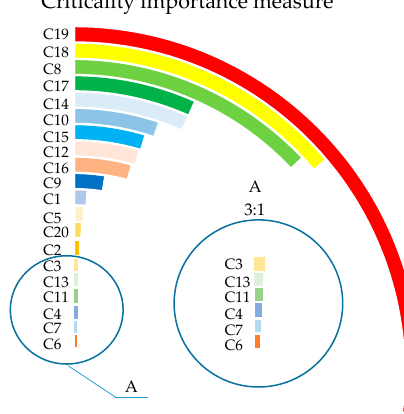
Figure 7. Radial bar chart of BIM.